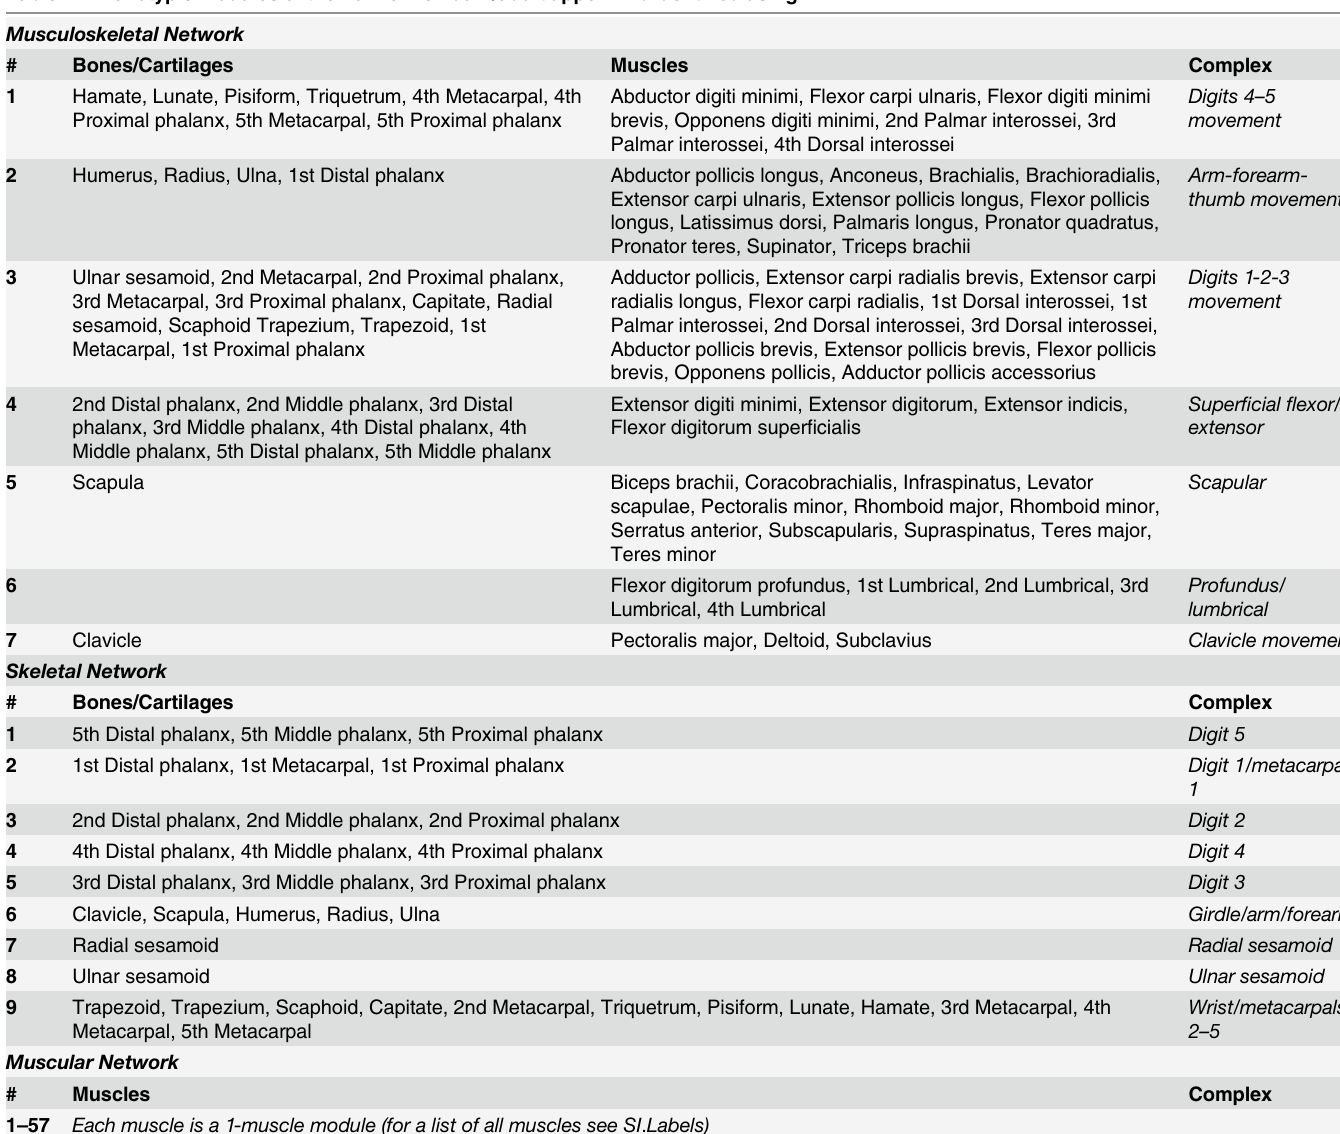
Table 1. Phenotypic modules of the normal newborn/adult upper limb identified using